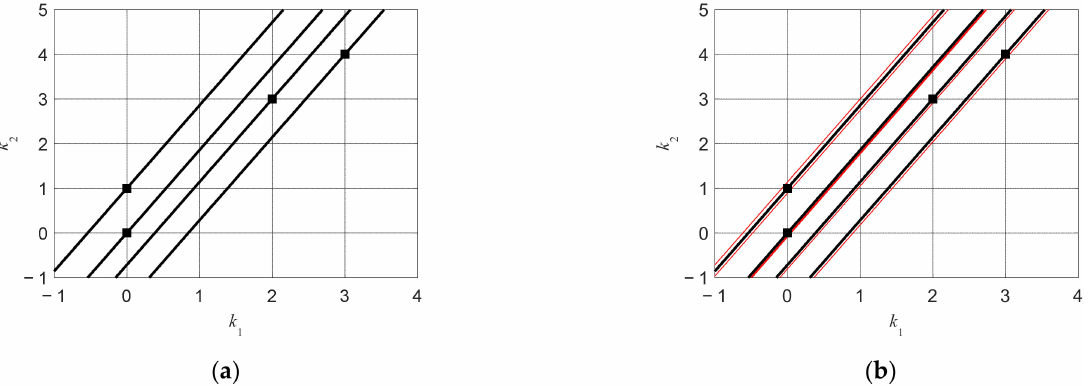
Figure 2. Straight lines corresponding to ambiguity vectors with k 1 as its abscissa and k 2 as its ordinate. ( a ) Straight lines in the absence of noise. ( b ) Straight lines in the presence of